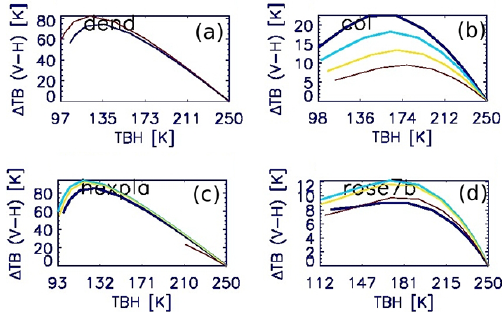
Figure 9. PolTranRad simulations of the 640GHz PD–TB V re- lationship for four different ice habits: (a) snowflake dendrite, (b) hexagonal plate, (c) cylindrical column, and (d) bullet rosette with seven branches. All frozen particles are assumed to be hori- zontally aligned. The red and blue in the snowflake dendrite sim- ulation correspond to D me = 200 and 300µm, respectively. In the remaining panels, red, yellow, cyan, and blue denote D me = 200, 300, 400, and 500µm,